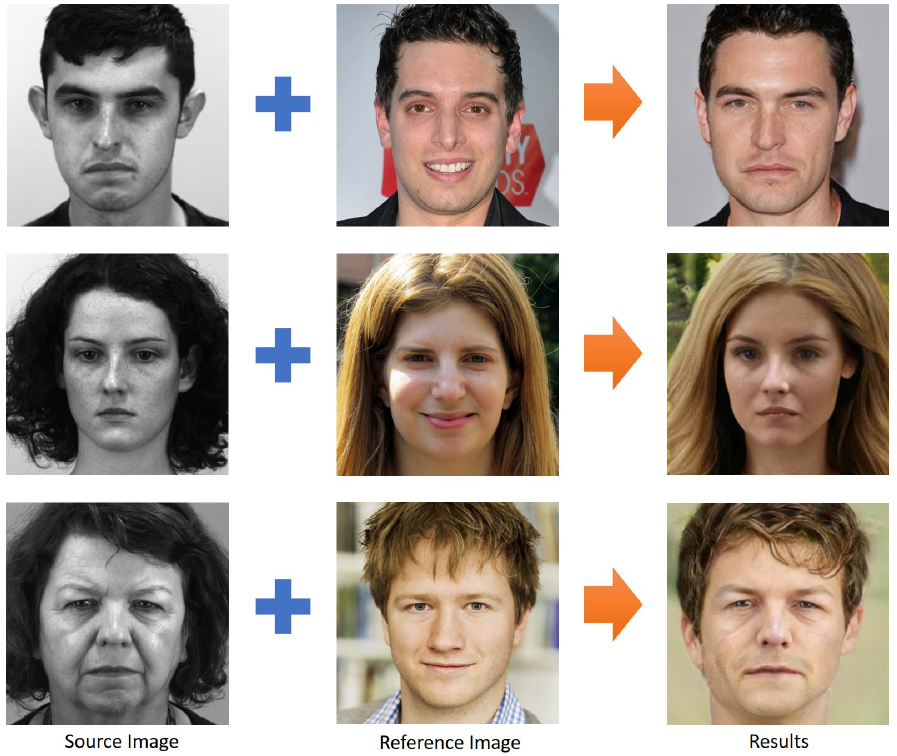
Figure 2. Style transfer using StarGANv2, also known as reference-guided image synthesis. The result exhibits facial features of the source image (taken from SAMM-LV dataset [8]), while taking the style extracted from the reference image (taken from FFHQ dataset [28]). StarGANv2 is capable of transferring style for both gender realistically. Inter-gender style transfer is also possible as shown in the bottom